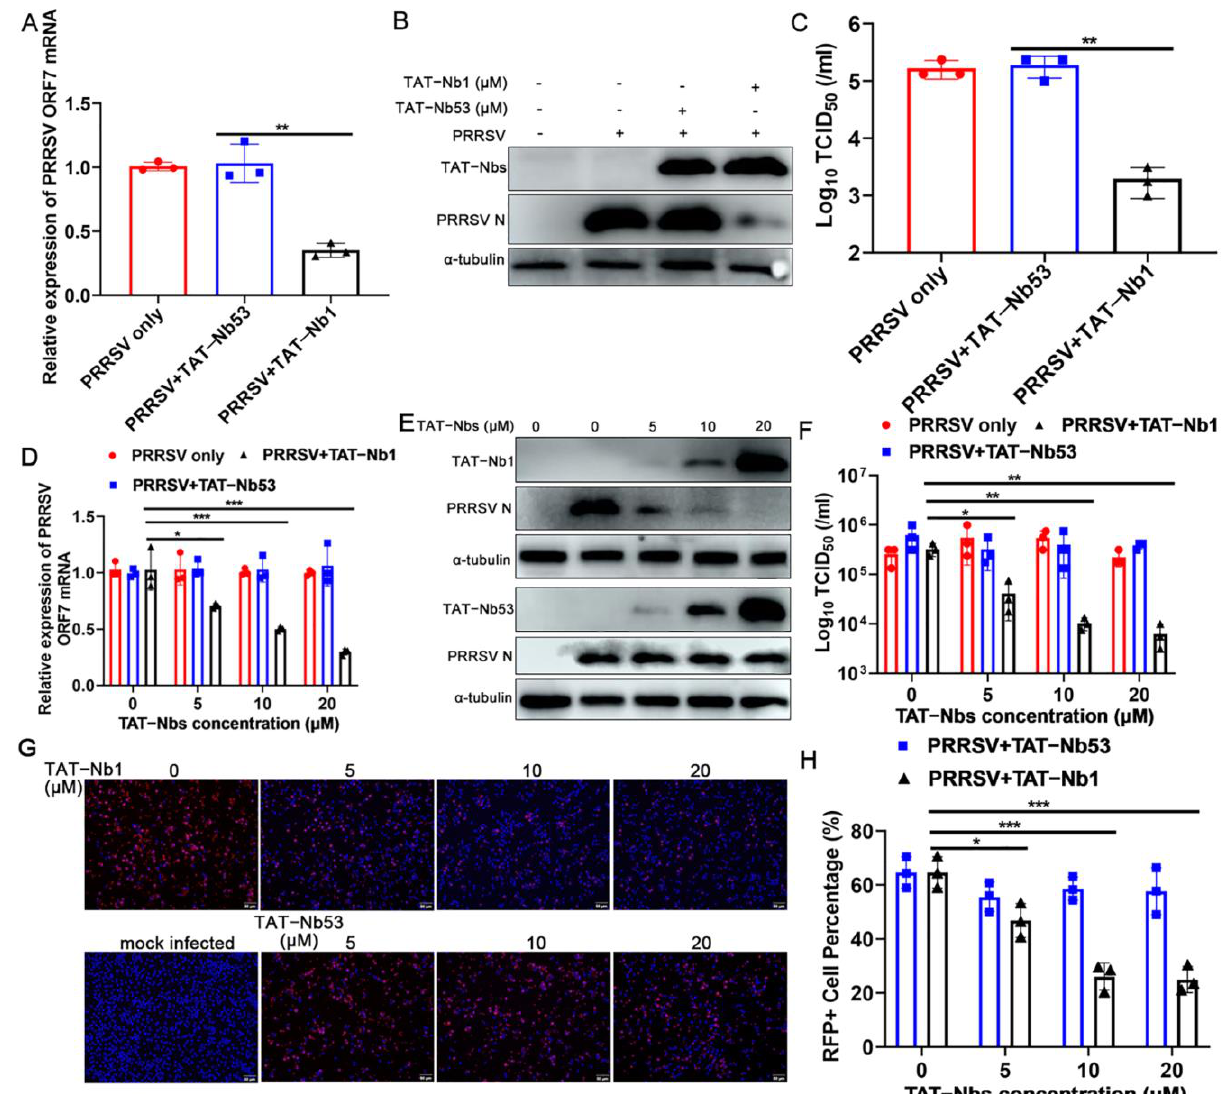
Figure 5. TAT - Nb1 inhibits PRRSV replication in PAMs. PAMs were seeded in 6 - well plates (2 × 10 6 /well) and incubated overnight at 37 ℃ with 5% CO 2 followed by treatment with 20 μM TAT - Nb1 or - Nb53 for 6 h and infected with 0.01 MOI of PRRSV. Cells and supernatants were harvested at 36 hpi to detect the expression of PRRSV ORF7 mRNA using qPCR ( A ), the expres- sion of N protein using Western blot ( B ), and supernatant viral titers using TCID 50 ( C ), respective- ly. PAMs were seeded in 6 - well plates (0.5 × 10 6 /well) and incubated with 0, 5, 10, or 20 μM TAT - Nb1 or - Nb53 for 6 h and then infected with PRRSV (0.01 MOI). At 24 hpi, the expression of PRRSV ORF7 mRNA and N protein was determined by qPCR ( D ), Western blotting ( E ), and IFA ( G , H ), respectively. Supernatant progeny viral titers were determined by TCID 50 ( F ). α - Tubulin was used as an internal control to normalize the quantitative data. Scale bar = 50 μm. Data are ex- pressed as the means ± standard deviations (SD) of the results of three independent experiments. P values were calculated using Student’s t test or analysis of variance (ANOVA). * , P < 0.05; ** , P < 0.01; *** , P < 0.001; ns, not significant.